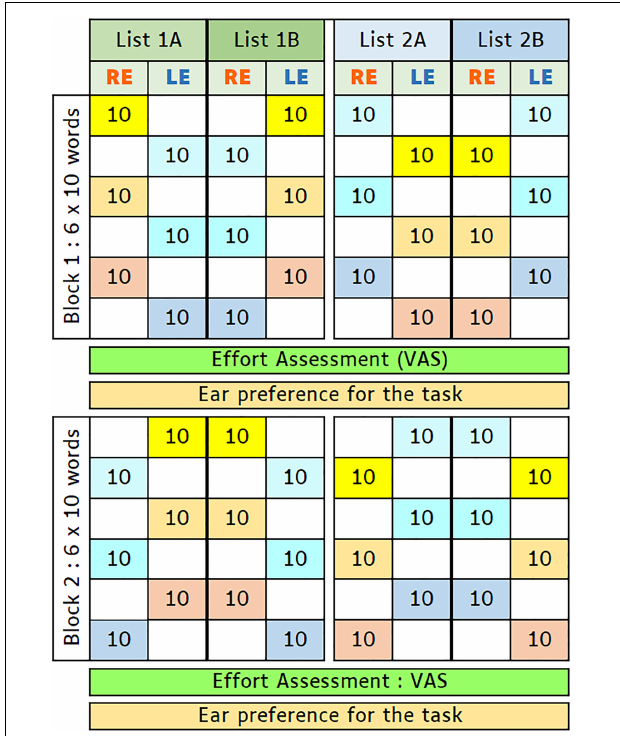
FIGURE 1 | Protocol used in the main speech perception task: 6 sets of 10 words (each set represented by a colored cell with number 10) were alternatively presented to left (LE) and right ears (RE) of a participant (block 1). After a pause, in which the participant was invited to answer two questions (about listening effort and the ear in which the task was the easiest), the same 6 sets of 10 words were presented (block 2), with inverted LE and RE channels (e.g., list 1A). Matching list 1B was used for another group of participants. Another pair of word lists (2A and 2B), differing by order of the word sets, was used for two other participant groups. Assignment of each word list to a participant was by order of inclusion in study, and each word list was used for 15 participants (i.e., for a total of 60